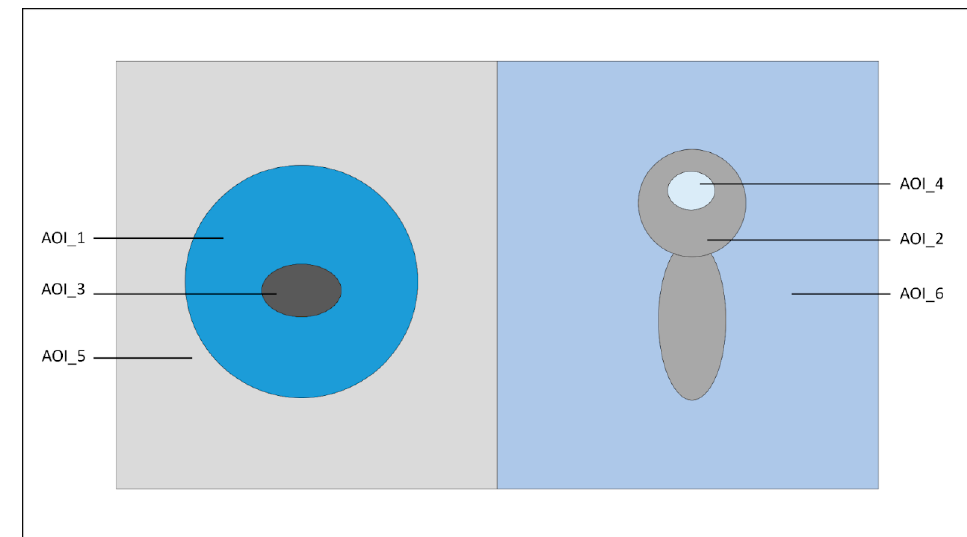
Figure 2. Eye tracker soothing dolls’ position and AOI.